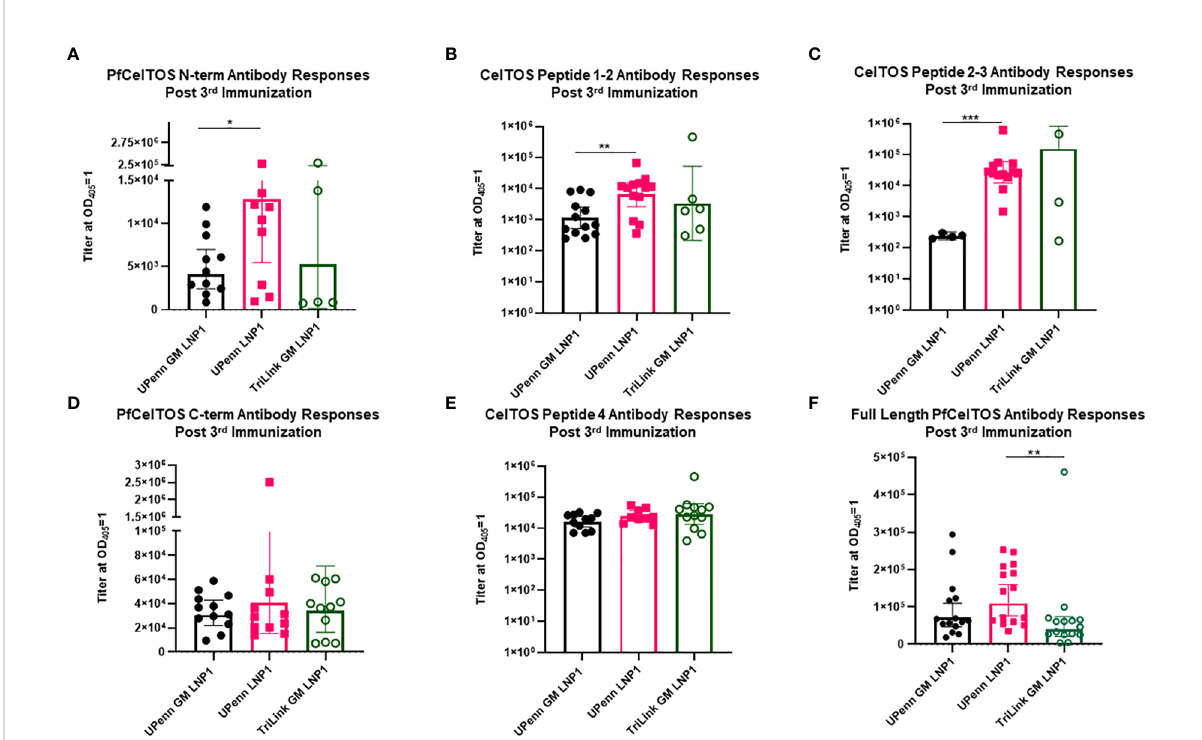
FIGURE 5 Fine speci fi city of antibody responses. Sera from mice that were immunized IM thrice at a three-week interval with 10µg mRNA pfceltos UPenn N- glycosylation site modi fi ed (GM) in LNP1 (UPenn GM LNP1), or without N-glycosylation modi fi cation (UPenn LNP1) that were one-methylpseudouridine (m1 Y )-5 ′ -triphosphate, and cellulose af fi nity puri fi ed or with TriLink pfceltos mRNA that were N-glycosylation site modi fi ed (GM) in LNP1 (TriLink GM LNP1) and were y -pseudouridine and 5-methylcytosine modi fi ed were characterized for antibody speci fi cities by ELISA against (A) PfCelTOS N-term, (B) CelTOS Peptide 1-2, (C) CelTOS Peptide 2-3, (D) PfCelTOS C-term, (E) CelTOS Peptide 4 and (F) Full length PfCelTOS protein ( n = 15 per group). Antibody titers are reported as the geometric mean and 95% con fi dence interval of the dilution required to achieve an OD 405 = 1. Statistical analysis was performed using a Mann-Whitney test (*p<0.05, **p<0.01,